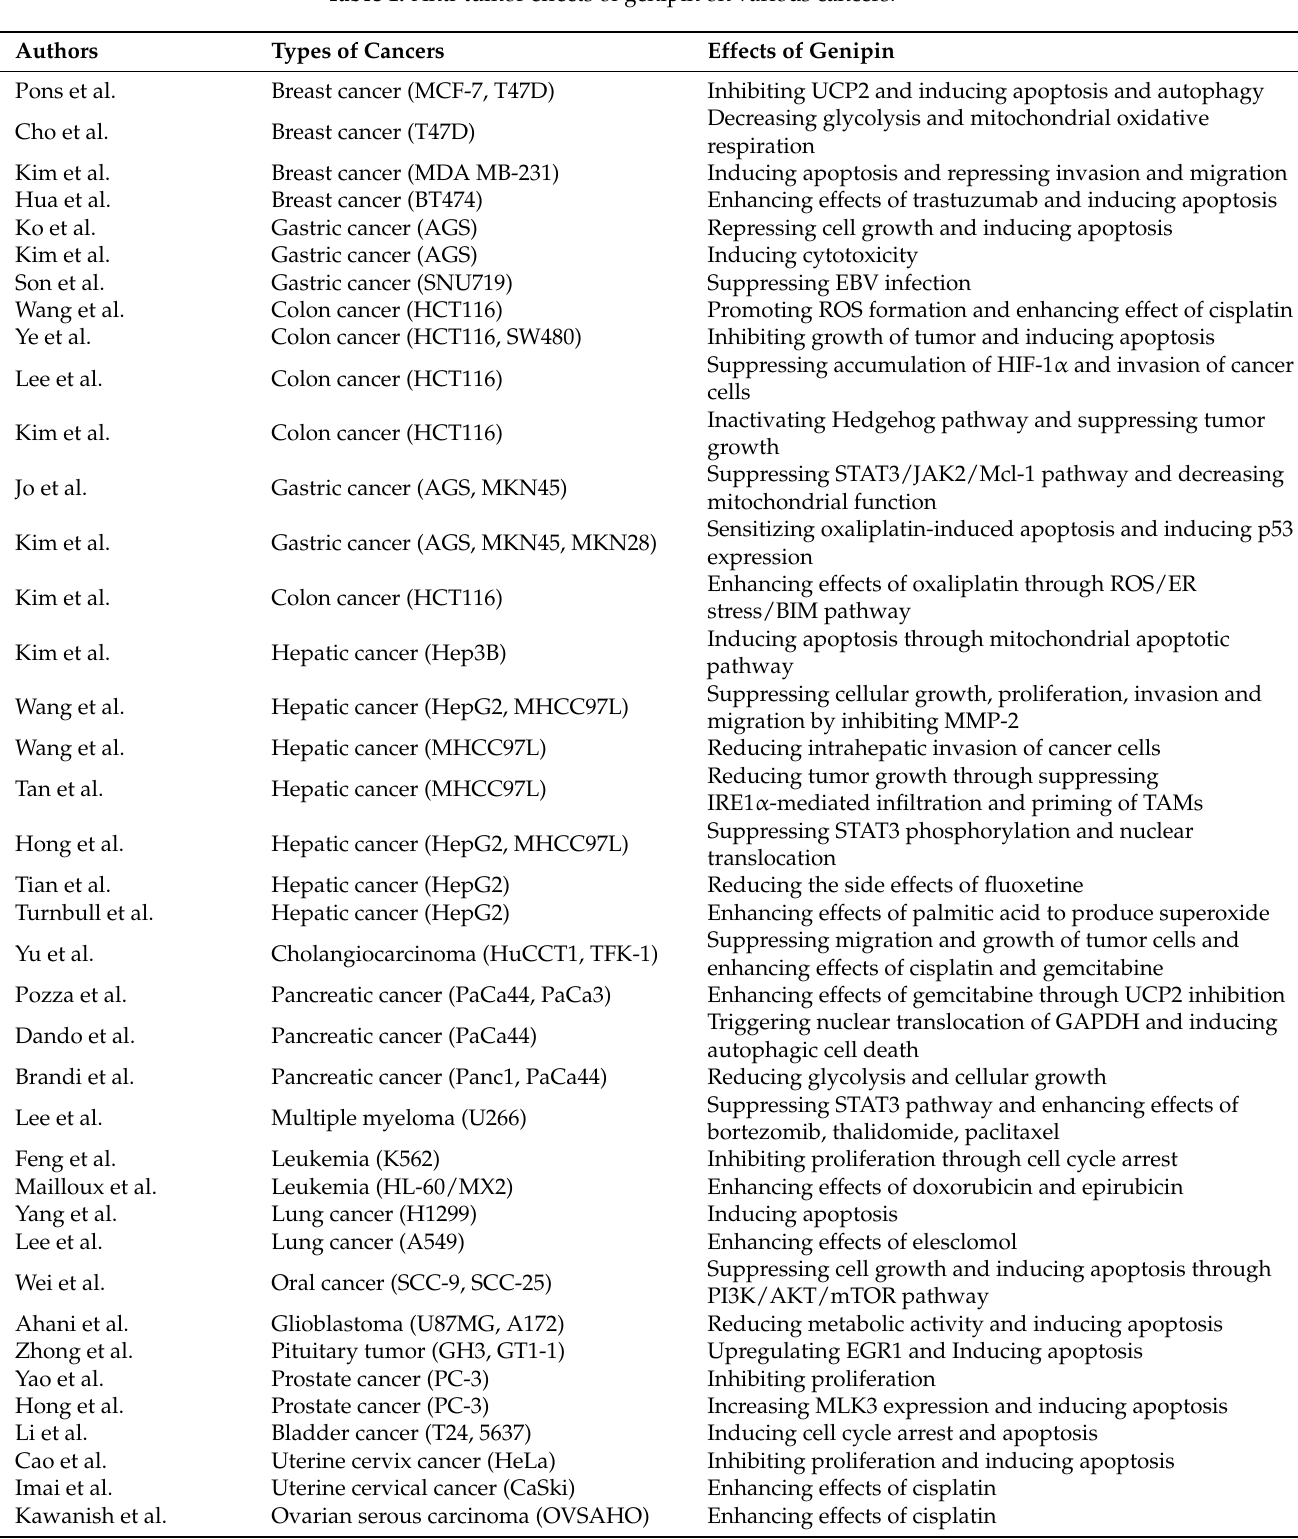
Table 1. Anti-tumor effects of genipin on various